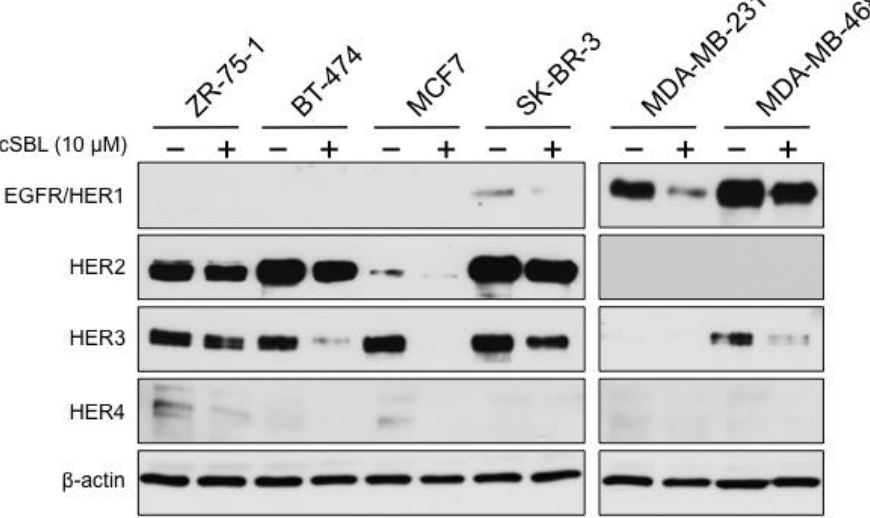
Figure 4. Effects of cSBL on the expression levels of ErbB family proteins in breast cancer cell lines (ZR-75-1, BT-474, MCF7, SK-BR-3, MDA-MB-231, and MDA-MB-468). Cells were treated with cSBL (10 µM) for 72 h and the expression levels of ErbB family in each cell line were detected by western blotting.